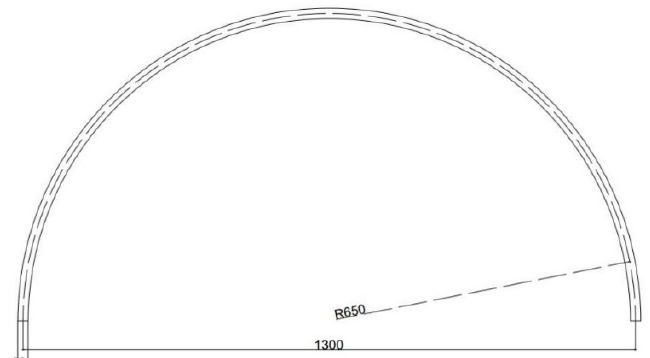
Figure 1. Design of the semi-hard copper pipe of 5 m × 22 mm × 1 mm.